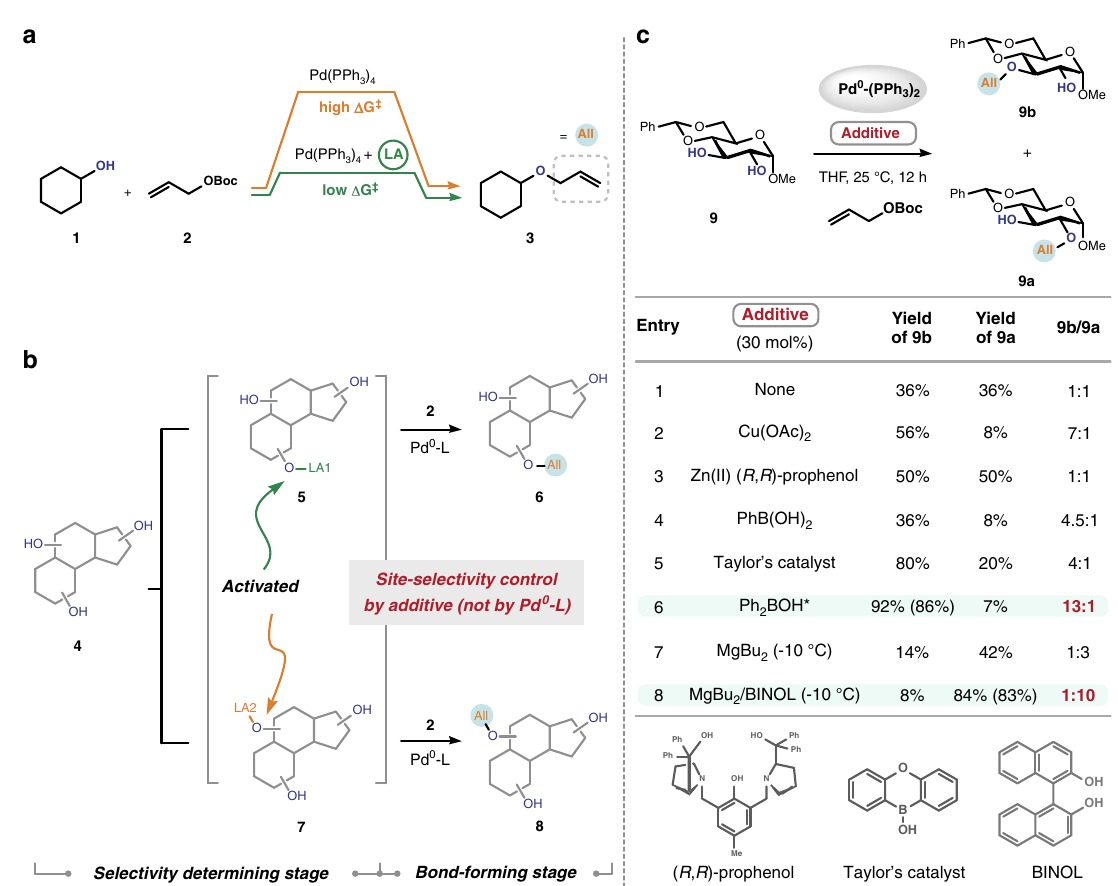
Fig. 2 Mechanistic underpinning and reaction design. a The Pd-catalyzed O -allylation of aliphatic alcohols is accelerated by addition of Lewis acids. b Our reaction design: the use of different Lewis acids (LA) to control site-selectivity. c Initial realization of site-switchable modi fi cation of polyols by exchanging additives. ‡ Reactions were performed on a 0.2 mmol scale. Product ratios were determined by 1 H-nuclear magnetic resonance (NMR) analysis of crude reaction mixtures. Yields in parenthesis are isolated yields. Pd 0 -(PPh 3 ) 2 used in this study was generated in situ from Pd 2 dba 3 • CHCl 3 and PPh 3 . * Generated in situ from the commercial Ph 2 BOCH 2 CH 2 NH 2 . Ac acetyl, Ph phenyl, Boc t -butoxycarbonyl, Bu butyl, THF tetrahydrofuran, BINOL 1,1 ’ -bi-2-naphthol, dba